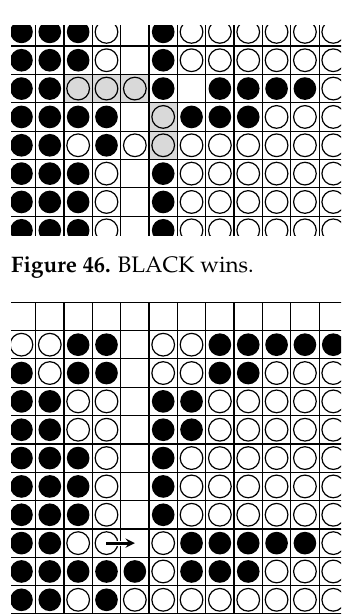
Figure 45. BLACK comes in.